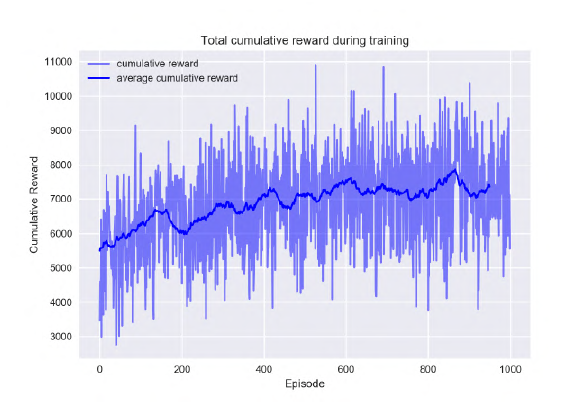
Figure 5. Cumulative reward throughout the training episodes. The solid line represents the average cumulative reward and the shaded area its